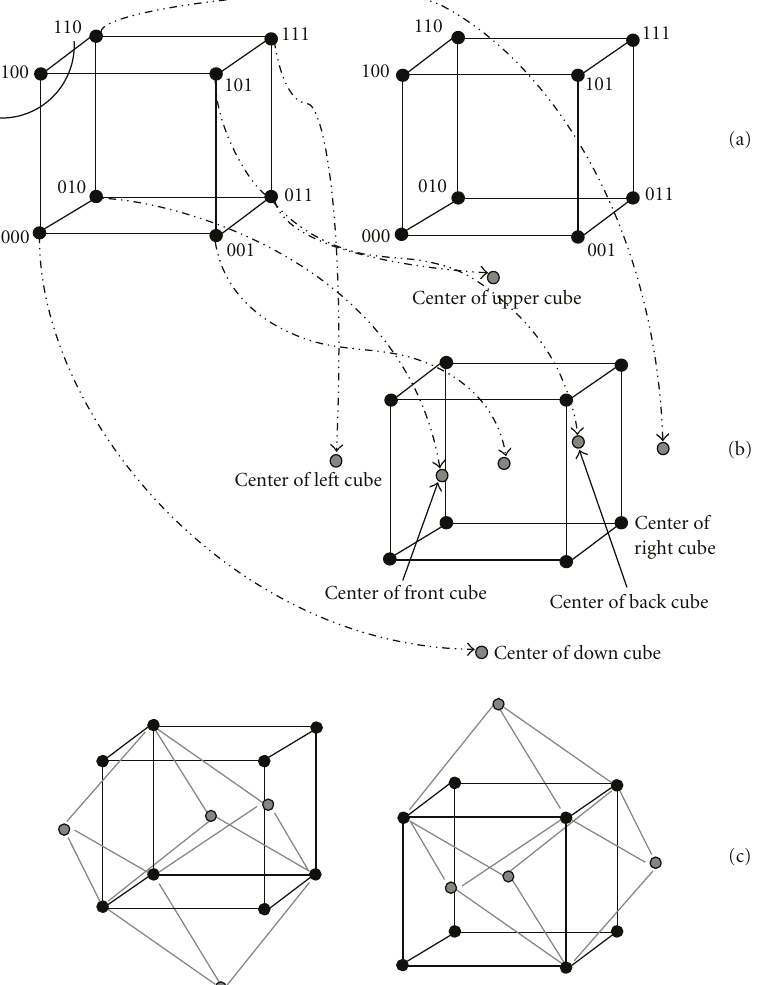
Figure 9: Extracting nodes from an established